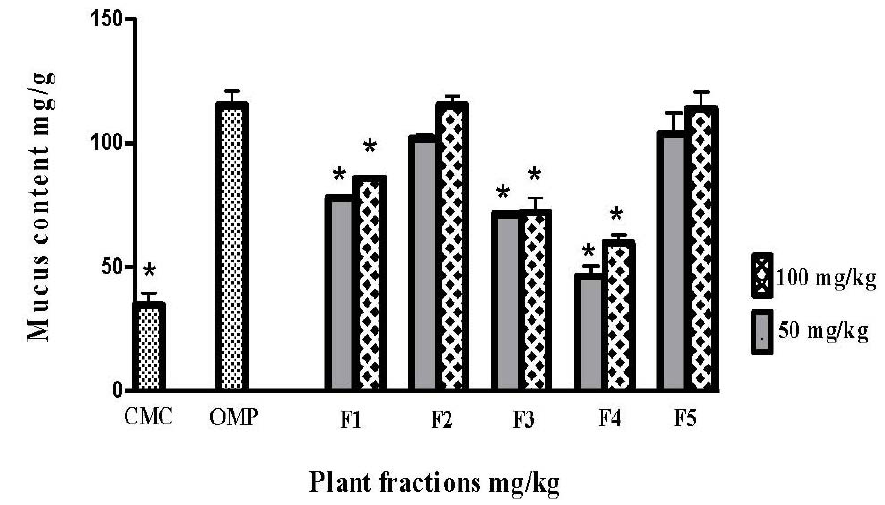
Figure 4. Effect of the fractions obtained from Polygonum minus on the mucus content in gastric tissue. Data are expressed as mean ± SEM ( n = 6) * significantly different in comparison to omeprazole, p < 0.05 using one-way ANOVA.